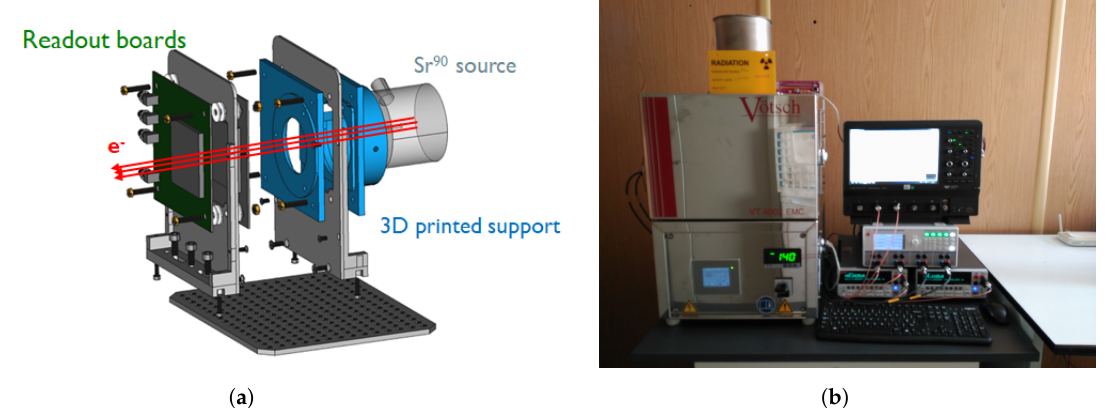
Figure 11. ( a ) Sketch and ( b ) photograph of the Sr-90 setup in the